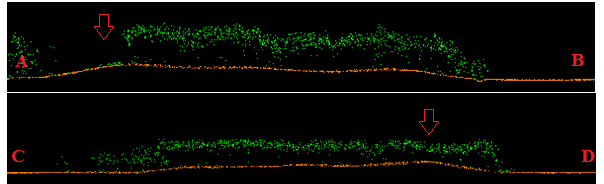
Figure 10. Microstructure in the forested area - elevation profile with vegetation cover – object